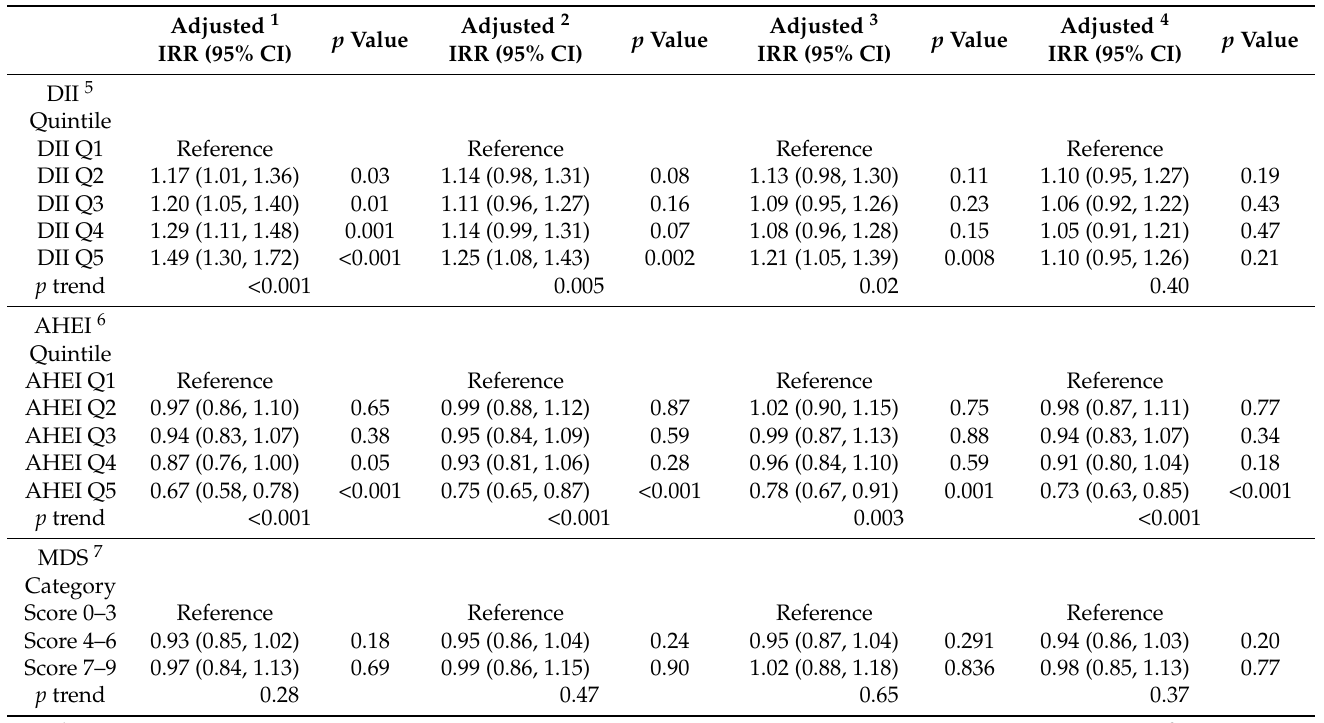
Table 3 presents the associations of dietary indices at baseline with diabetes incidence from multi-variable Poisson regression models. Baseline DII was positively associated with diabetes incidence in model 1 after adjusting for age, sex, SEIFA, smoking status, drinking status, family history of diabetes and physical activity level ( p trend < 0.001). Only quintile 5, the most pro-inflammatory diet, showed significant association after adjusting for BMI [IRR 1.25; 95% CI 1.08, 1.43, model 2; p trend = 0.005] and for BMI and WHR combined [IRR 1.21; 95% CI 1.05, 1.39, model 3, p trend 0.019]. However, after adjusting for region of origin (model 4) the association with DII became non-significant ( p trend = 0.402). Only quintile 5 (most adherent diet quintile) of AHEI-2010 at baseline showed a significant association with diabetes [IRR 0.67; 95% CI 0.58, 0.78;] in model 1 and there was a significant trend ( p < 0.001) across quintiles. The association persisted after adjustment for BMI [IRR 0.75; 95% CI 0.65, 0.87 p trend < 0.001] and additional adjustment for WHR [IRR 0. 78; 95% CI 0.67, 0.91; p trend = 0.003] and region of origin [IRR 0.73; 95% CI 0.63, 0.85; p trend < 0.001]. Baseline MDS score showed no significant association with diabetes risk in the multivariable Poisson regression models. Table 3. Association of baseline dietary indices with diabetes adjusting for confounders.